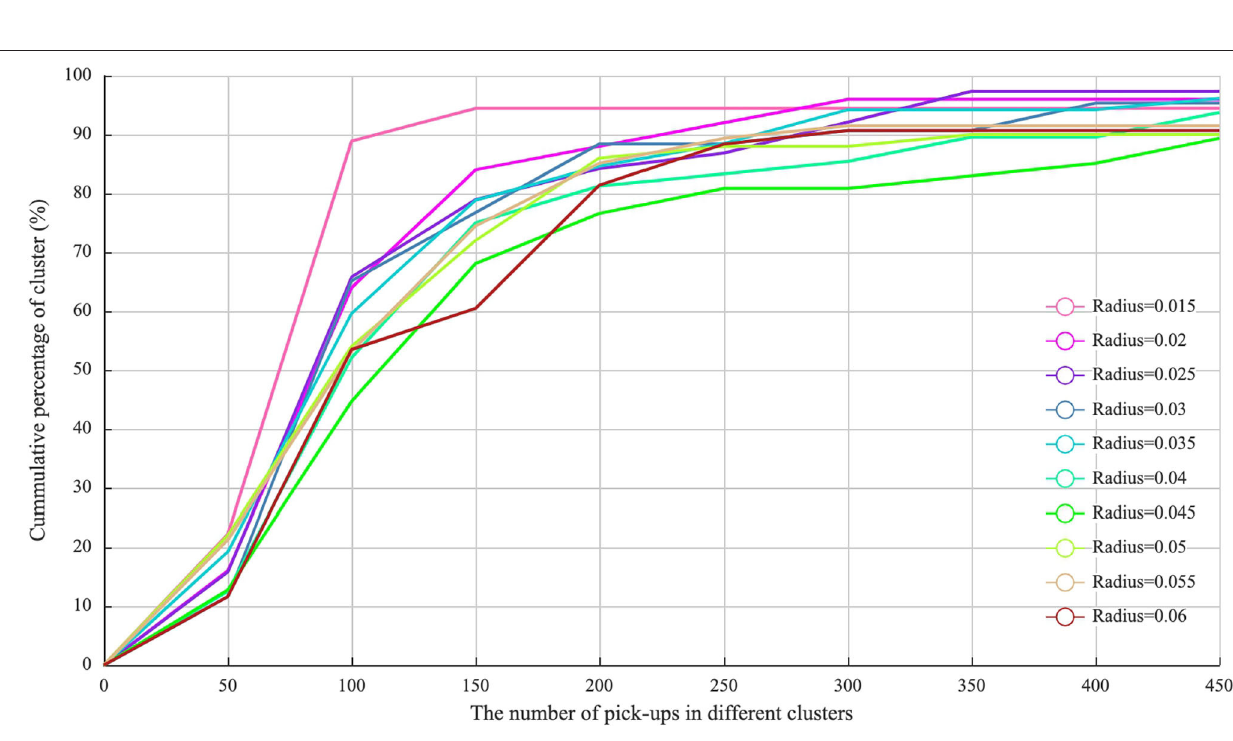
FIGURE 7 | Cumulative proportion of clusters of